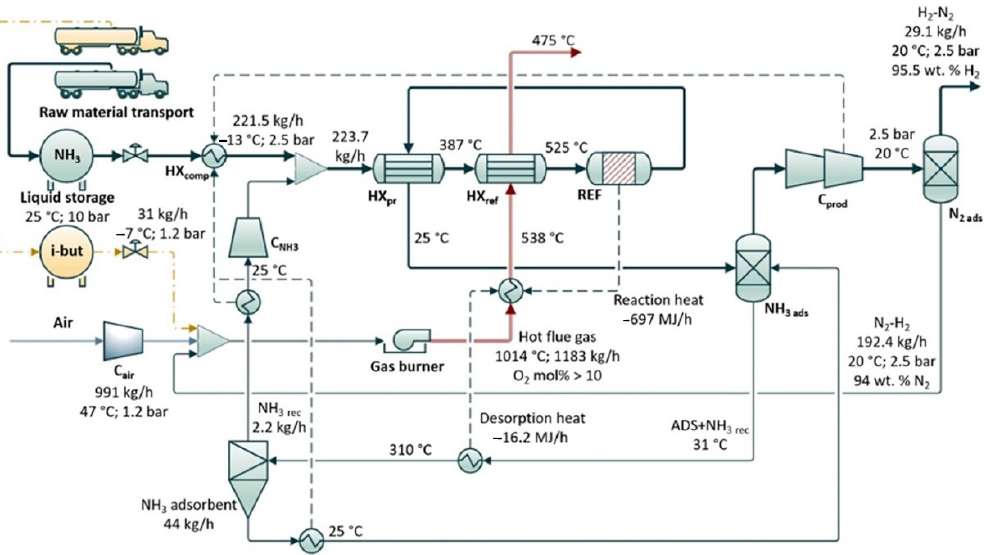
Figure 20. Schematic process flow diagram of the conversion of ammonia to hydrogen and the separation and purification for the simulation model at a 500 kW scale with the output of H 2 . Note: HX comp = compressor cooler; HXpr = preheater; HX ref = reformer heat exchanger mantle; REF = reformer; C = compressor; ads = adsorber. Reprinted with permission [48].